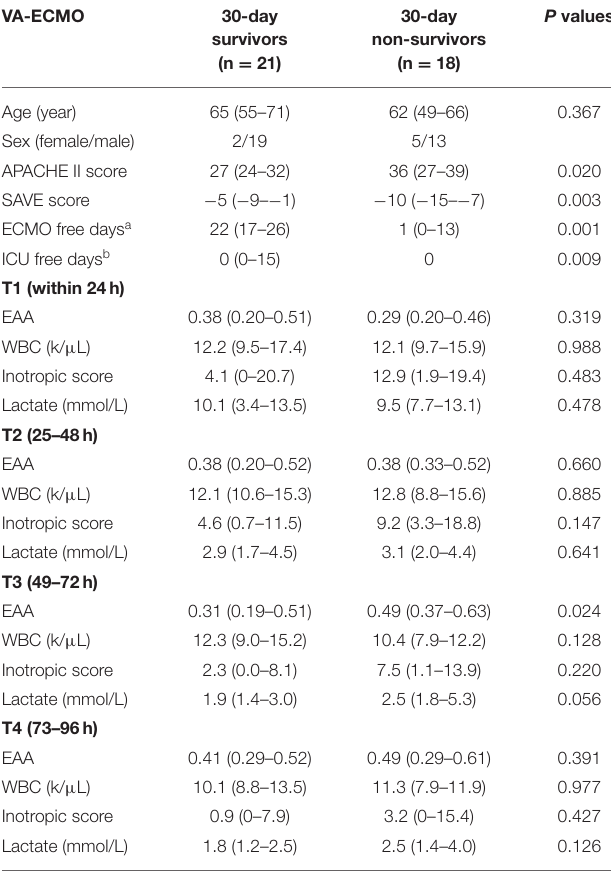
TABLE 2 | Data of 30-day survivors and non-survivors with